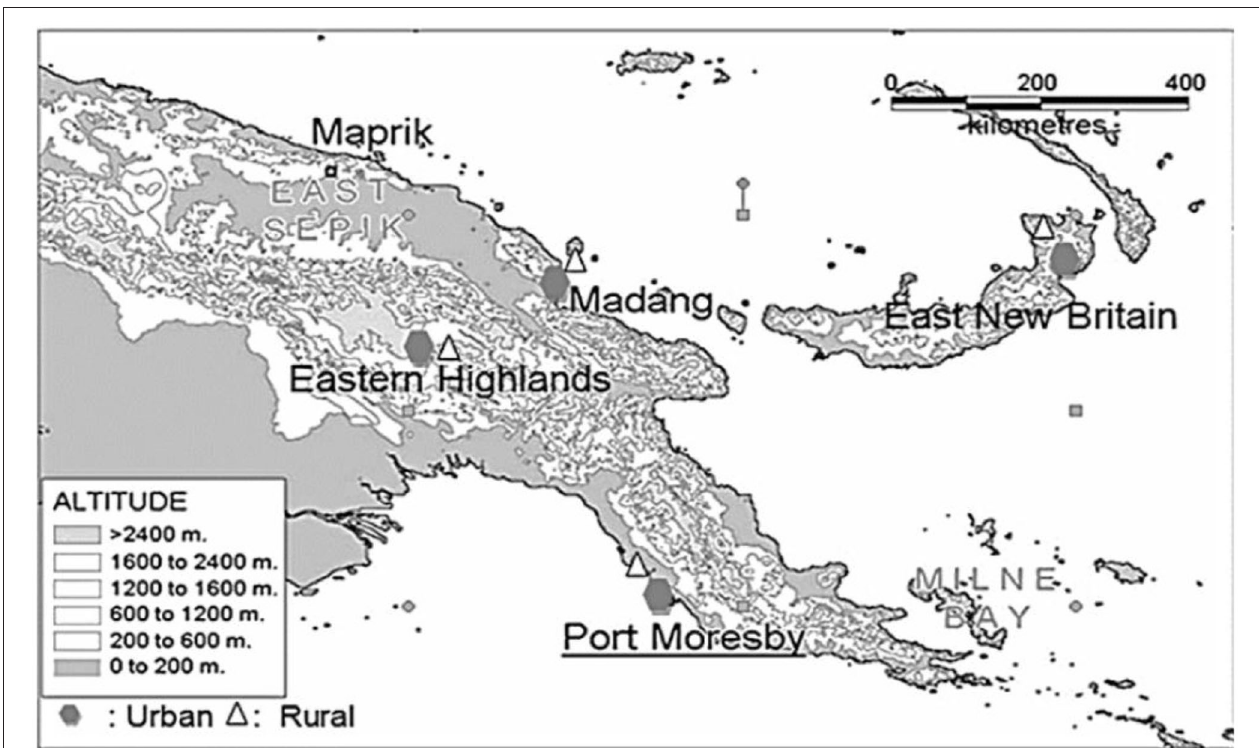
FIGURE 2 | Geographic coverage and surveillance sites of PNGIMR’s CHESS,